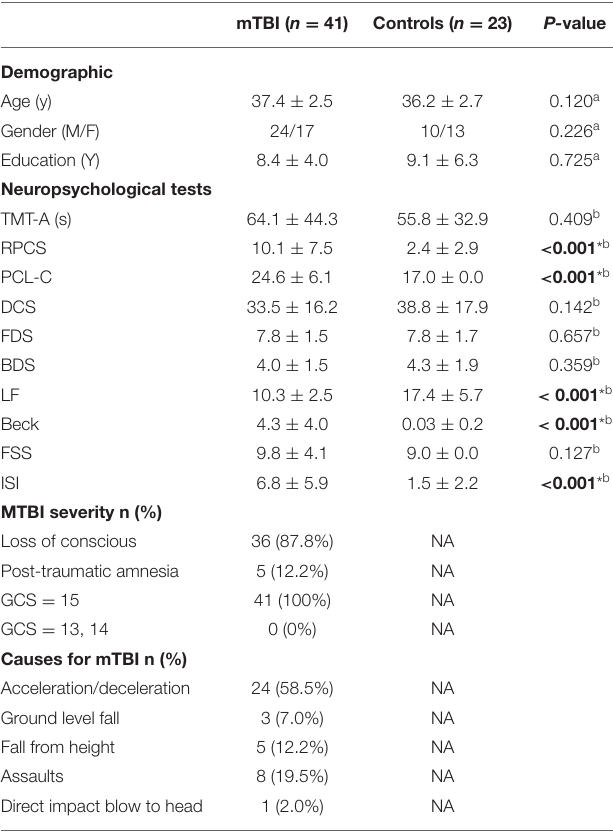
TABLE 1 | Summary of demographics and neuropsychological information for patients with mTBI and control